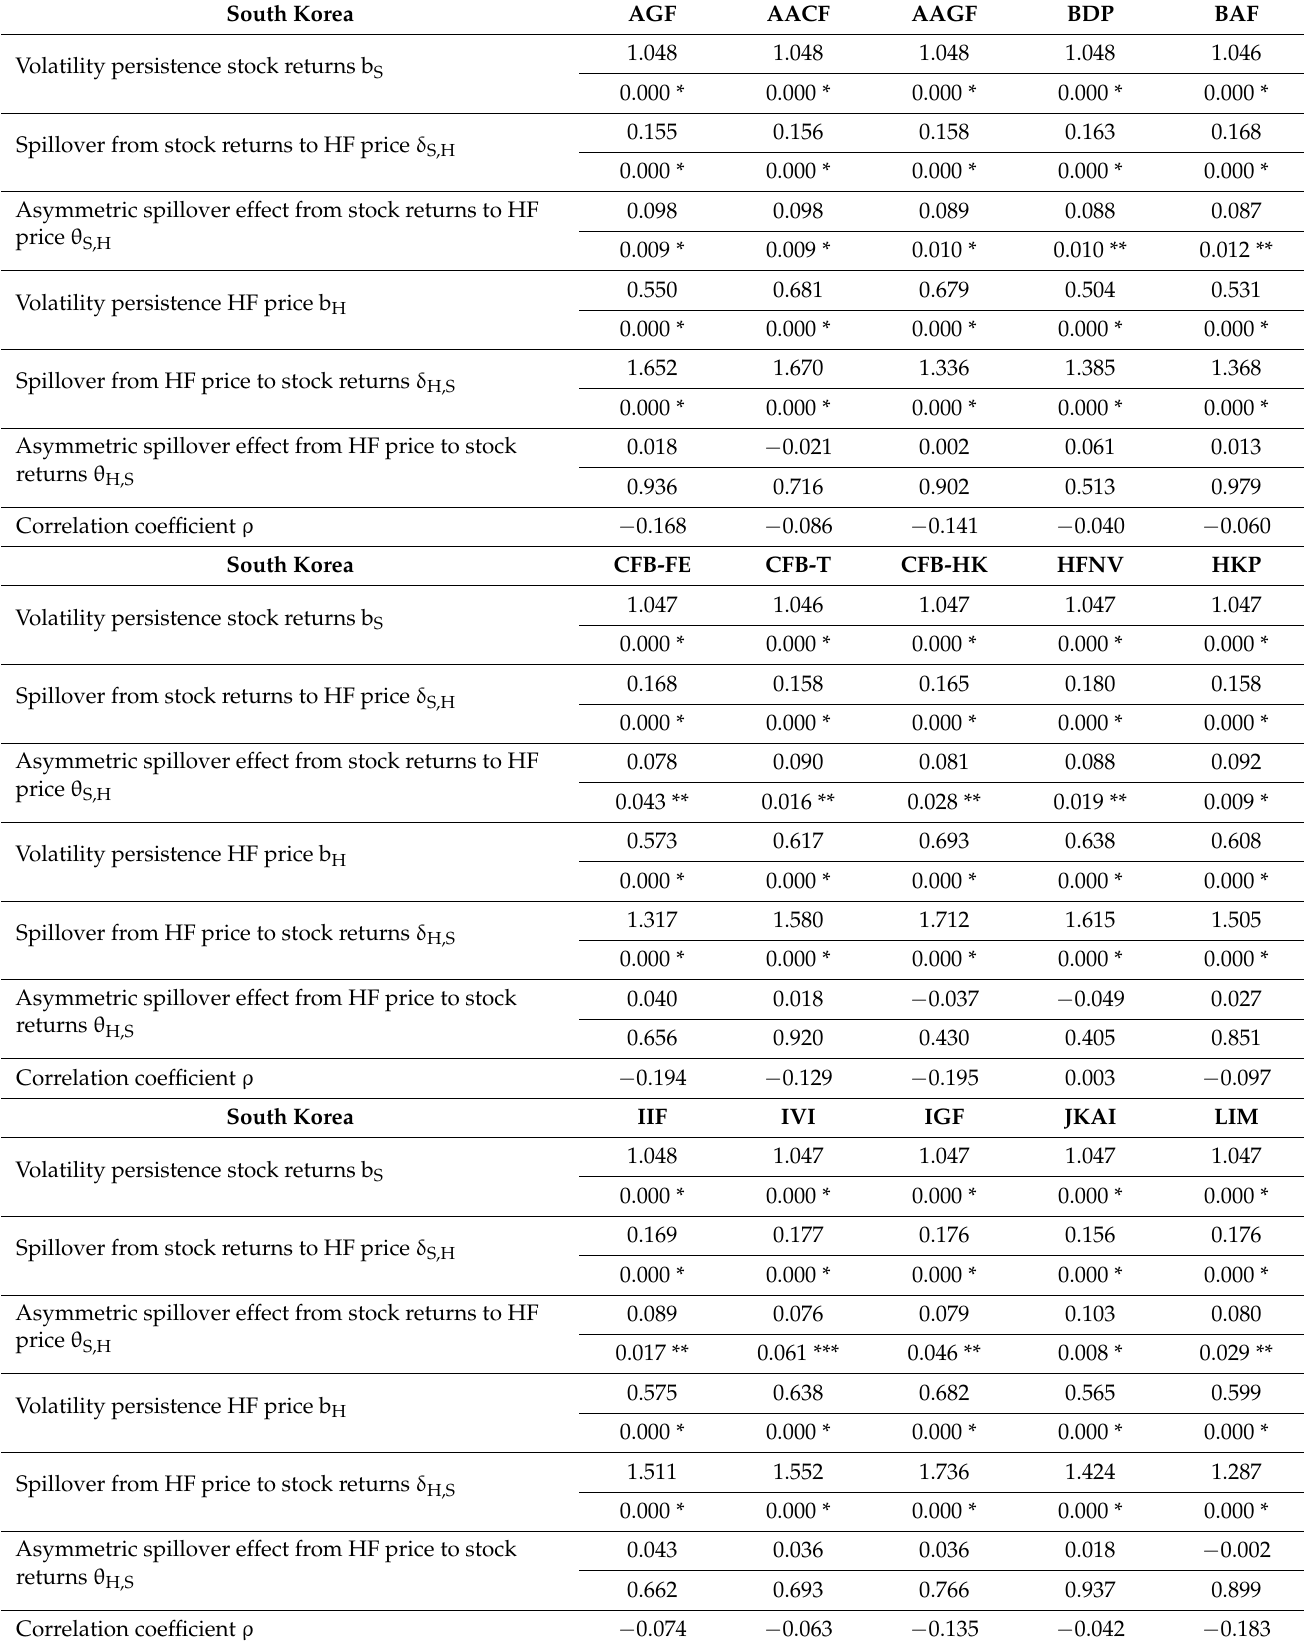
Table 7. Volatility spillover between the South Korean Stock Market (KOSPI) and Hedge Fund